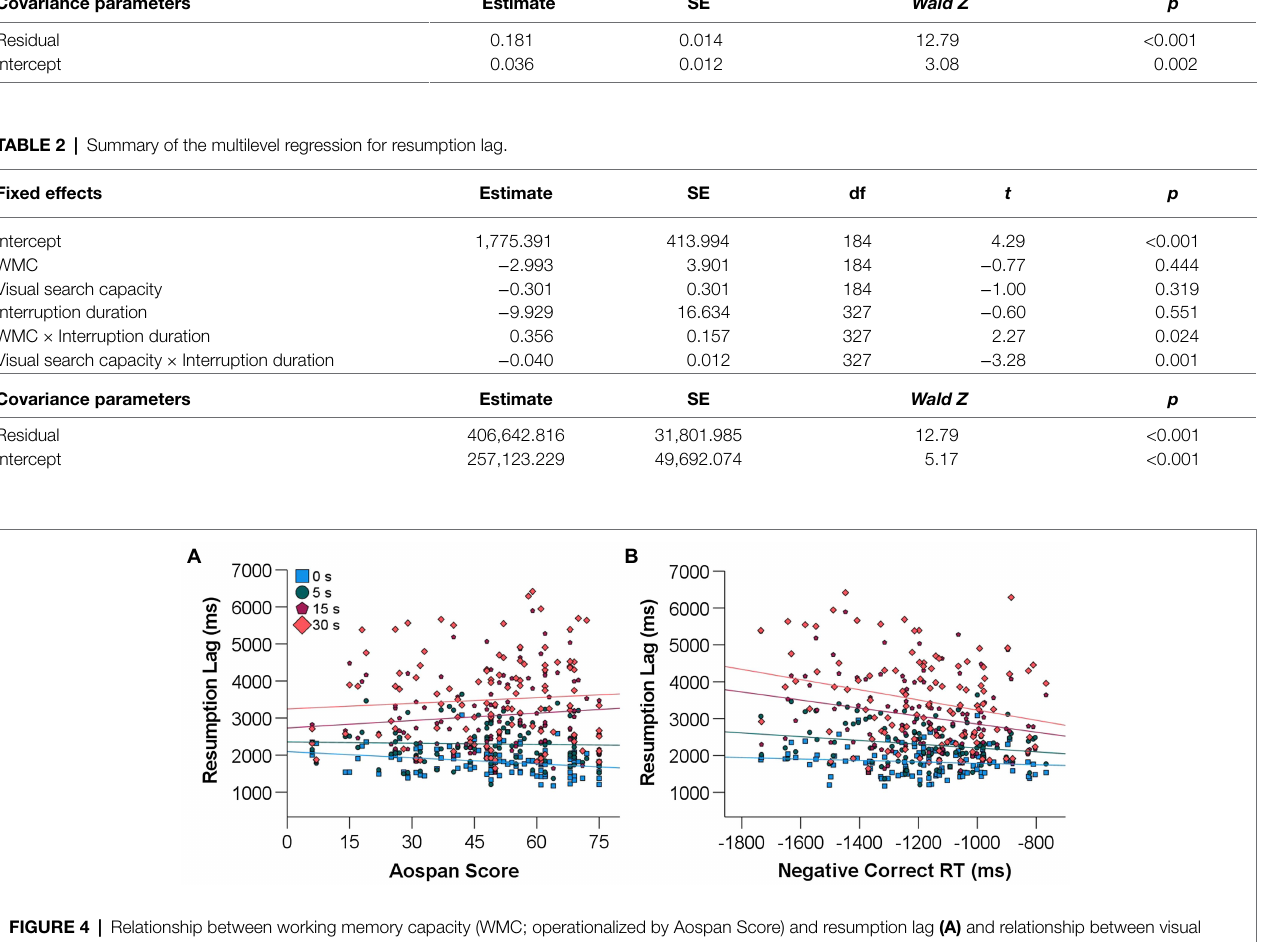
FIGURE 4 | Relationship between working memory capacity (WMC; operationalized by Aospan Score) and resumption lag (A) and relationship between visual search capacity (operationalized by negative correct RT) and resumption lag (B) for each interruption duration (‘0 s’ corresponds to uninterrupted